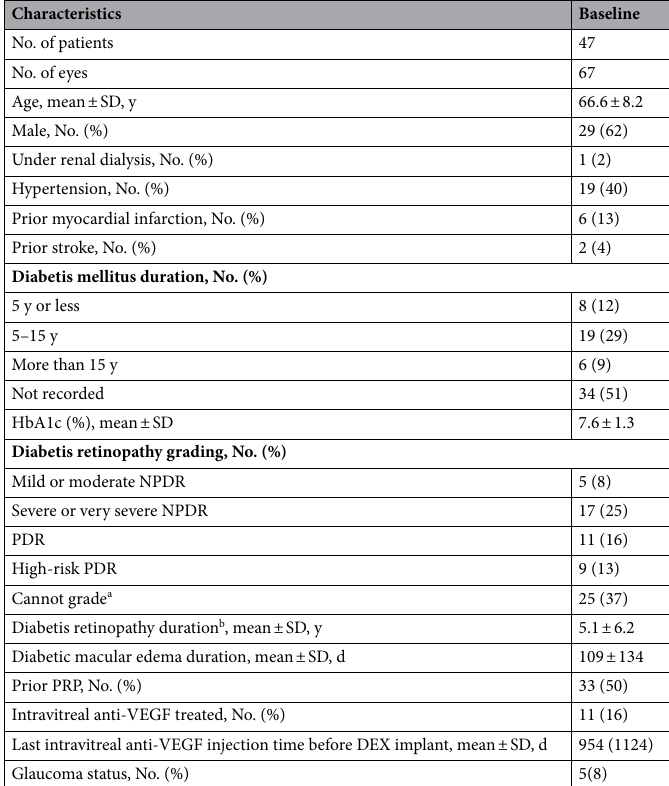
Table 1. Demographic and baseline characteristics. a Eyes with prior PRP were non-gradable except for those with neovascularization. b Valid n = 48. Abbreviation: anti-VEGF anti-vascular endothelial growth factor, DEX implant dexamethasone intravitreal implant, NPDR nonproliferative diabetic retinopathy, PDR proliferative diabetic retinopathy, PRP panretinal